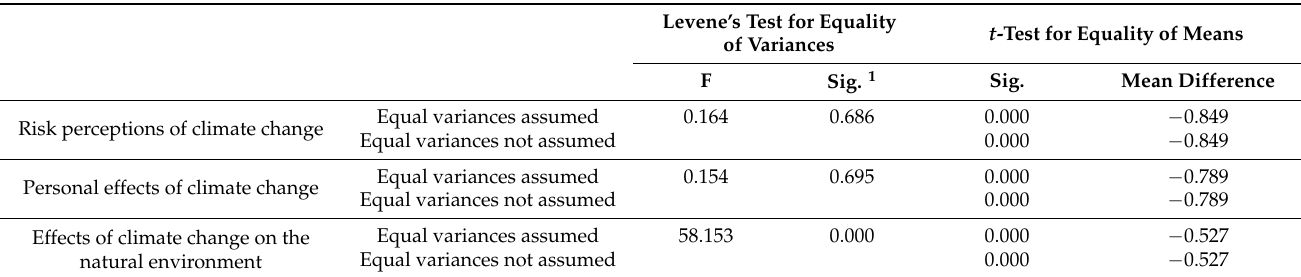
Table 6. Independent samples t -test